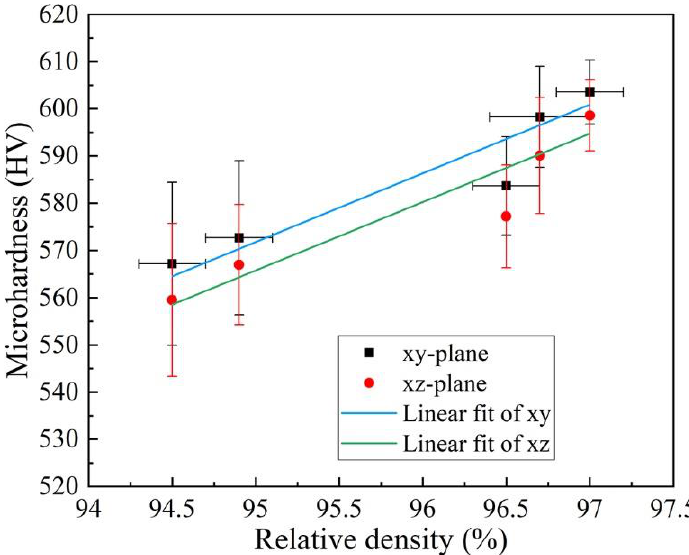
Figure 12. Relationship between the microhardness and relative density (RD).